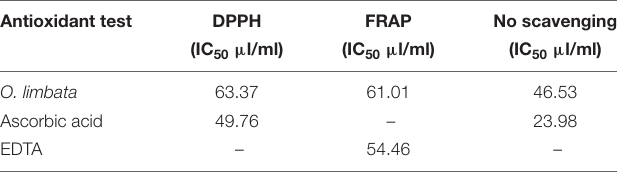
Frontiers in Neuroscience |